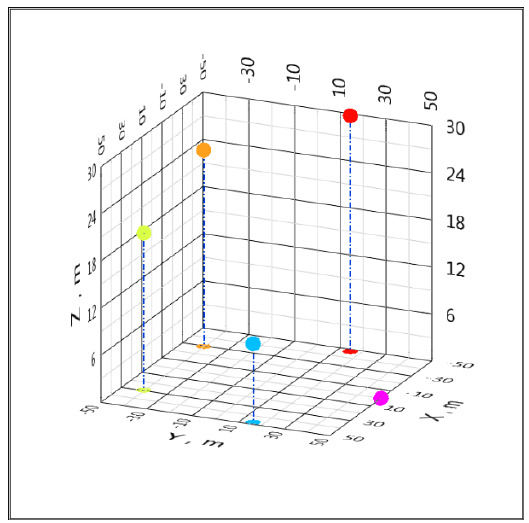
Figure 4. The location of the BS in the example of a local positioning system (LPS) system.